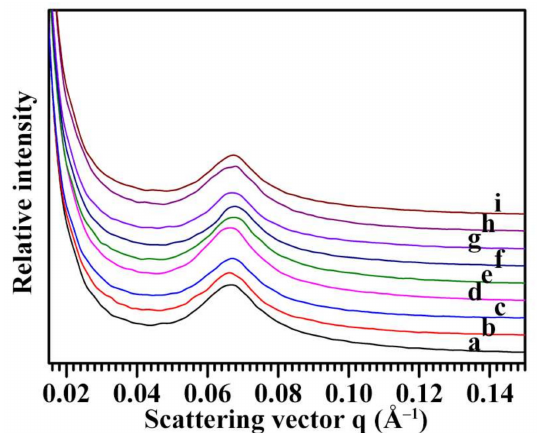
Figure 5. SAXS spectra of starches from variety 3113 ( a ), Benlizi ( b ), Dahongpao ( c ), Erqingzao ( d ), Heishanzhai 7 ( e ), Mi 5 ( f ), Mi 6 ( g ), Yangguang ( h ), and Yanshanhong ( i ).